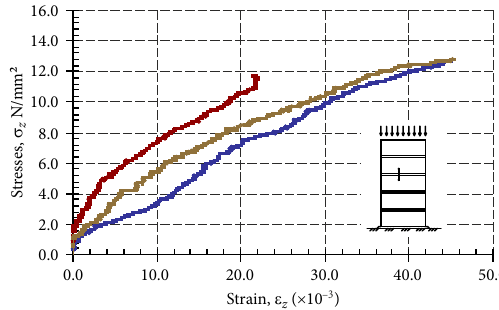
Fig. 13. The dependence of the Serial B6 masonry specimens of bed joint stress under the short-term